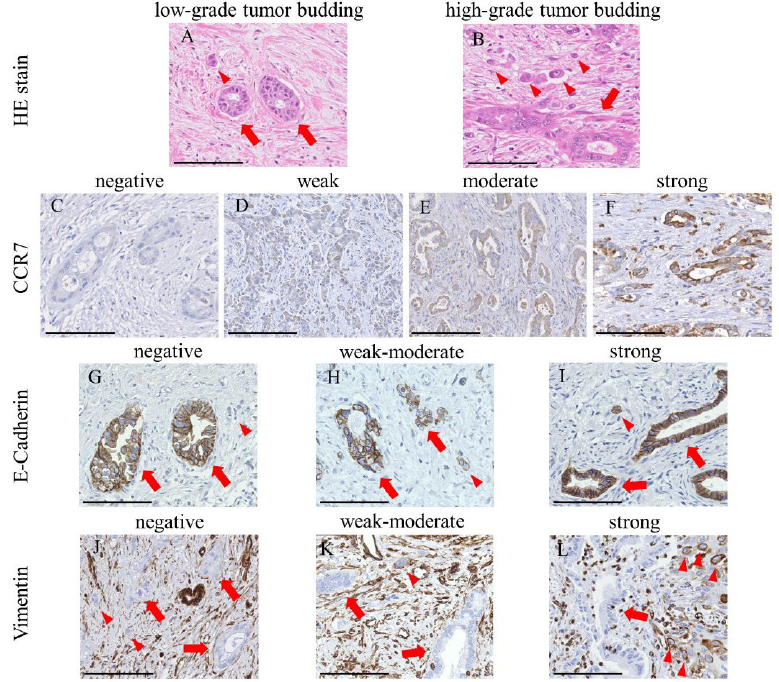
Figure 1. CCR7 expression and epithelial–mesenchymal transition status in perihilar cholangiocarcinoma. ( A , B ) Representative images of hematoxylin and eosin staining for low-grade ( A ) and high-grade ( B ) tumor budding from n = 181 samples. The arrows and arrowheads indicate neoplastic glandular structures and tumor bud cells, respectively. ( C – F ) Immunohistochemical detection of negative ( C ), weak ( D ), moderate ( E ), and strong ( F ) CCR7 expression in tumor cells. CCR7 protein was detected in the cytoplasm and cell membranes of tumor cells and the surrounding lymphocytes. The staining intensity of strongly stained tumor cells was comparable to that of the surrounding lymphocytes. The arrows and arrowheads indicate neoplastic glandular structures and lymphocytes, respectively. ( G – I ) E-cadherin was detected in the cell membrane of neoplastic glandular structures, while tumor bud cells showed negative ( G ), weak–moderate ( H ), or strong ( I ) staining for E-cadherin. The arrows and arrowheads indicate neoplastic glandular structures and tumor bud cells, respectively. ( J – L ) Vimentin was not expressed in neoplastic glandular structures, while tumor bud cells displayed negative ( J ), weak–moderate ( K ), or strong ( L ) staining for vimentin. The arrows and arrowheads indicate neoplastic glandular structures and tumor bud cells, respectively. Scale bar = 100 µ